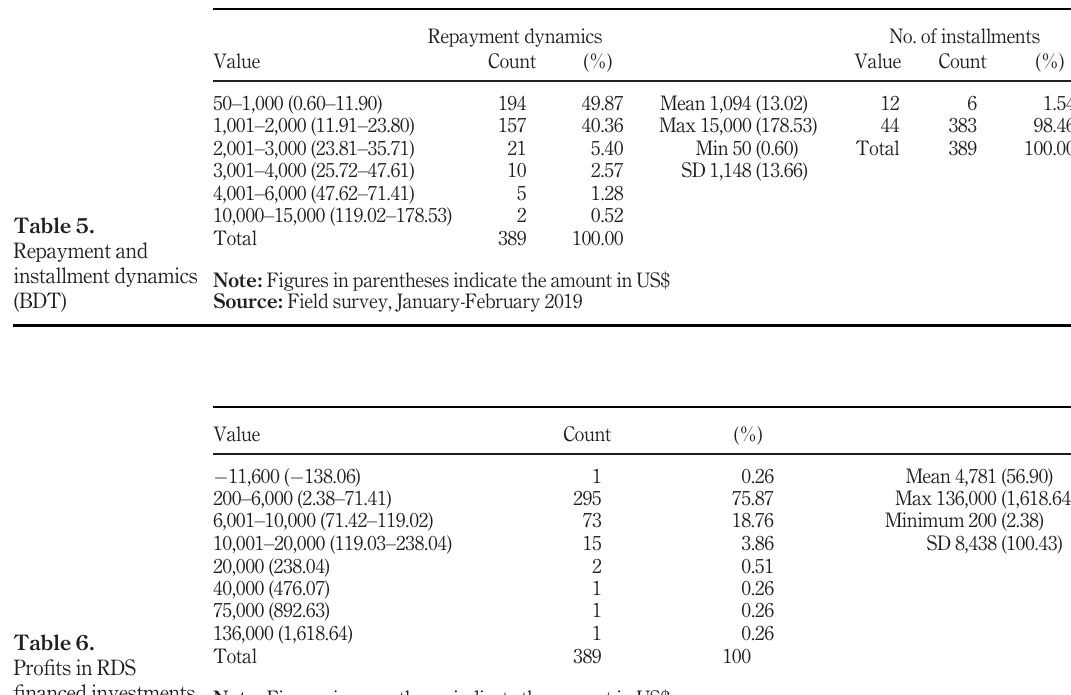
Table 6. Pro fi ts in RDS fi nanced